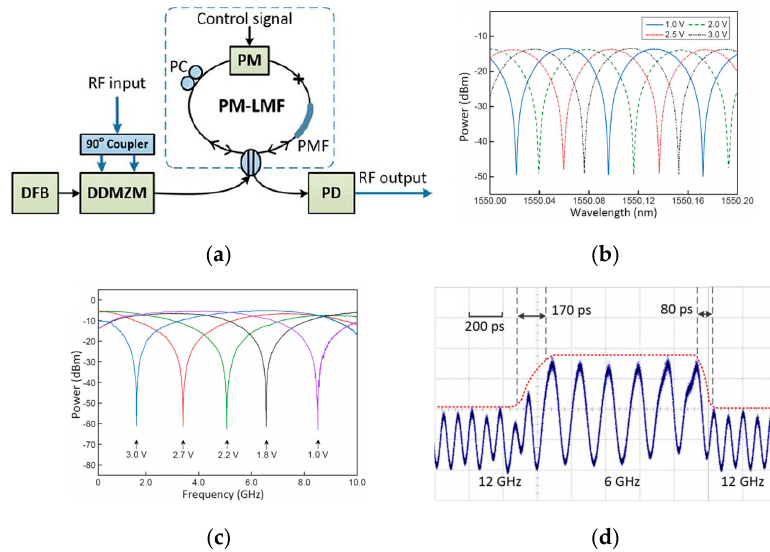
Figure 8. ( a ) Experimental setup of the PM-LMF-based MWP notch filter for RF signal switching. DFB: distributed feedback laser; DD-MZM: dual-drive Mach–Zehnder modulator; PM: phase modulator; PMF: polarization-maintaining fiber; PC: polarization controller; PD: photo detector; ( b ) Measured transmission optical spectra of the tunable PM-LMF at different control voltages. ( c ) Corresponding RF notch filter response at different control voltage; ( d ) Close-up of the frequency-hopping signal that switches between 6 GHz and 12 GHz.